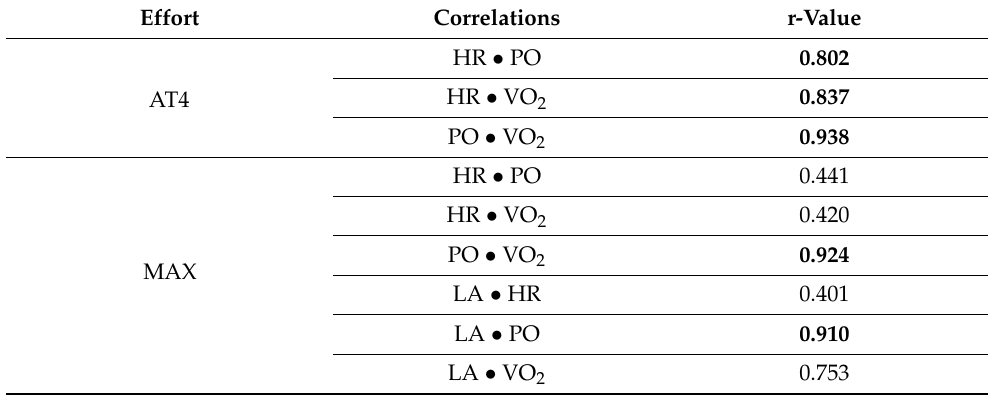
Table 7. Simple correlation coefficients between variables. Pooled data from 2018 and 2018 ( n = 6).